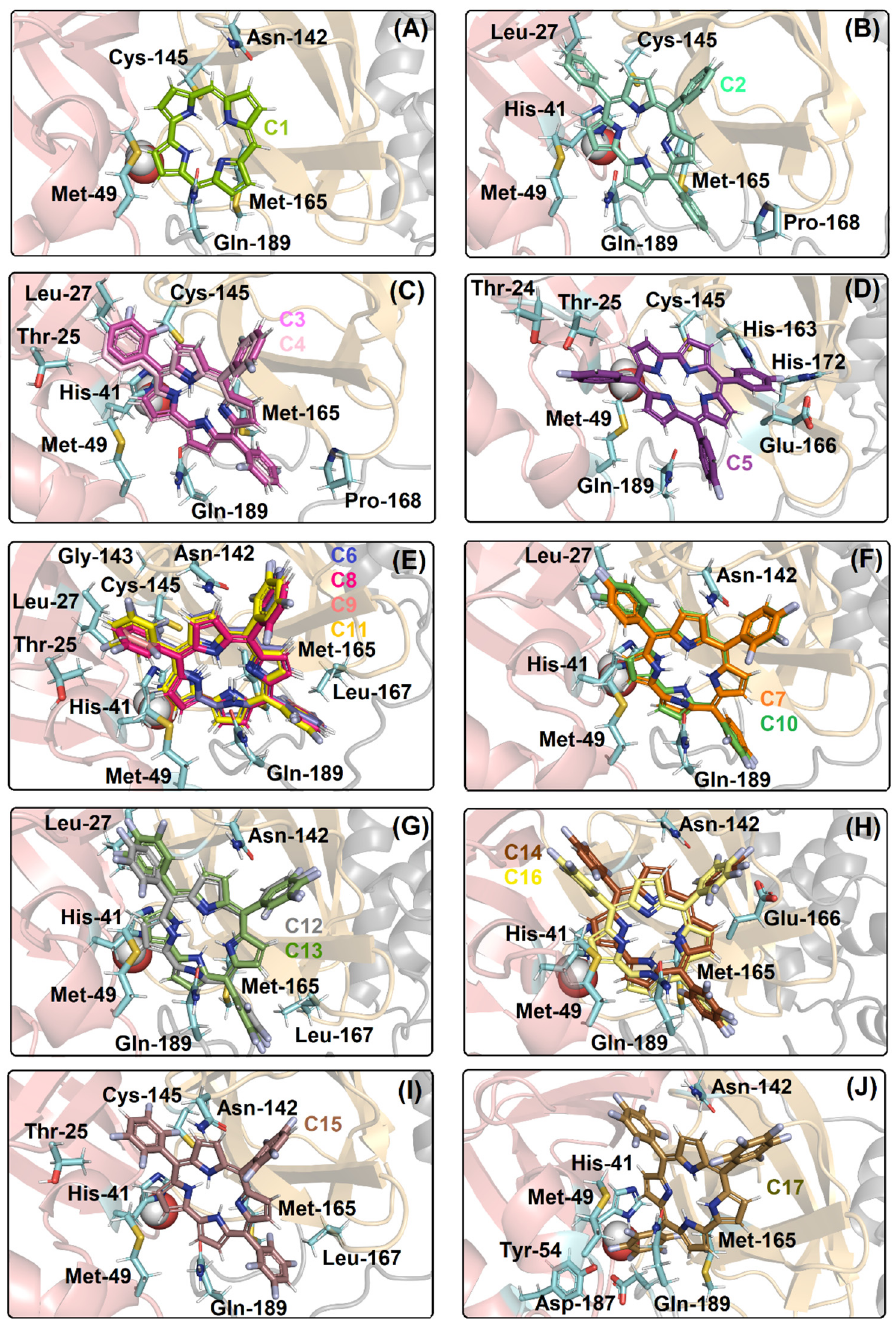
Figure 3. The best docking pose into the catalytic site of M pro for ( A ) C1 ; ( B ) C2 , ( C ) C3 , C4 ; ( D ) C5 ; corrole is represented as a sphere, while the selected amino acid residues that are interacting with the corrole structure are in stick representation in cyan. The M pro structure is in cartoon representation, being divided into domains I, II, and III in beige, light orange, and gray, respectively. The chemical structure and the corresponding carbon’s color of each corrole that was used in this study are in stick representation according to the 3D chemical structure of the Figure 1. The elements’ color: hydrogen, nitrogen, fluorine, and oxygen in white, dark blue, light blue, and red,